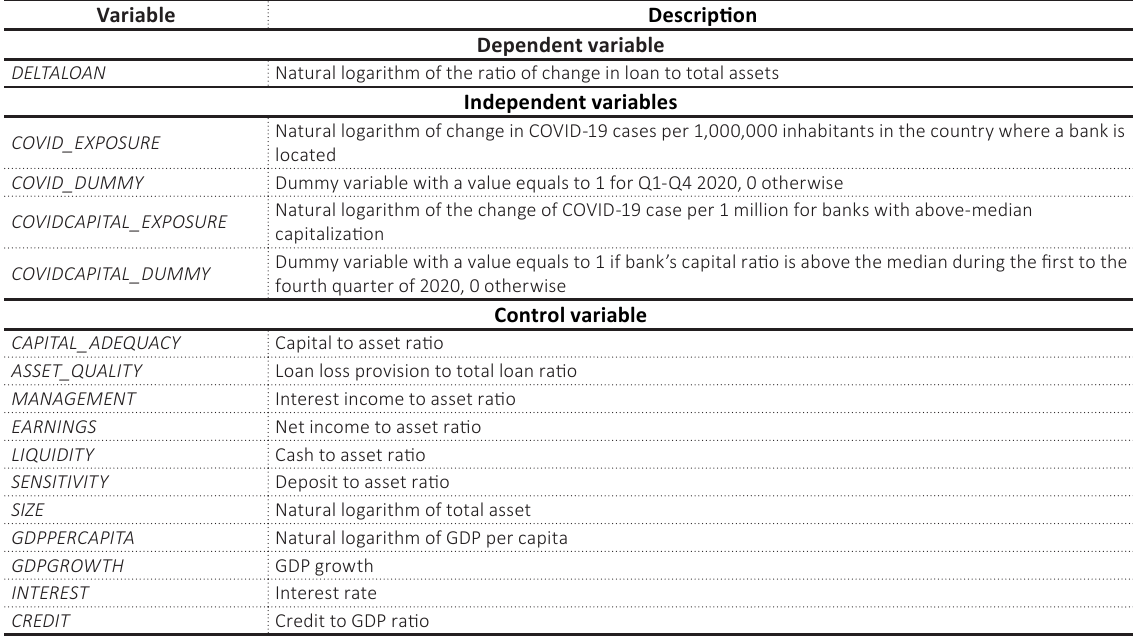
Table 1. Variables’ operationalization